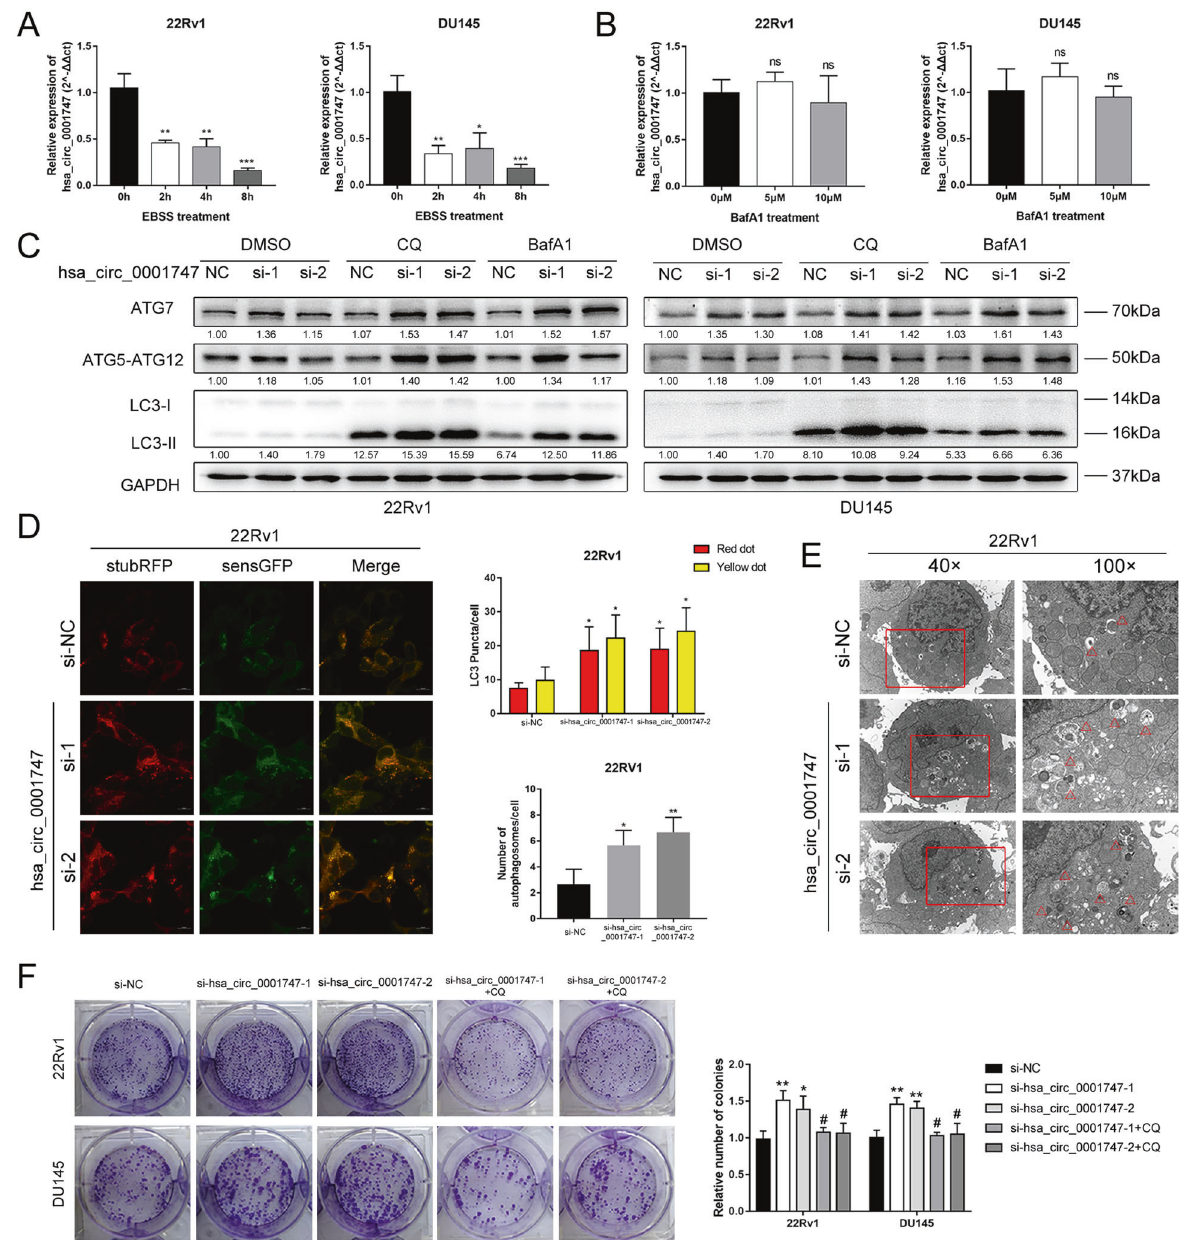
Fig. 8 Downregulation of hsa_circ_0001747 promoted autophagy induced proliferation in PCa. A Hsa_circ_0001747 was downregulated in EBSS treatment. B Impediment of autophagy displayed no effect on the expression of hsa_circ_0001747. C Western blotting con fi rmed knockdown of hsa_circ_0001747 enhanced autophagy-related protein expression. D Knockdown of hsa_circ_0001747 facilitated the autophagy fl ux, including the autophagosomes (yellow dots) and autophagolysosomes (red dots) formation in 22Rv1 cells. E Knockdown of hsa_circ_0001747 promoted the formation of autophagosomes in 22Rv1 cells. F CQ treatment rescued the promotion of proliferation induced by knockdown of hsa_circ_0001747 in PCa. Error bar indicates mean ± SD. “ ns ” and “ # ” indicates not signi fi cant. * P < 0.05, ** P < 0.01, *** P <